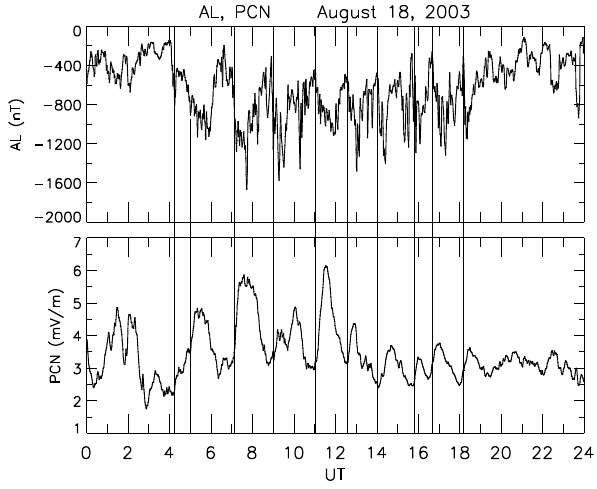
Fig. 3. AL (nT) and PCN (mVm − 1 ) indices for 18 August 2003. Onsets of AL excursions and corresponding PCN enhancements are marked by vertical